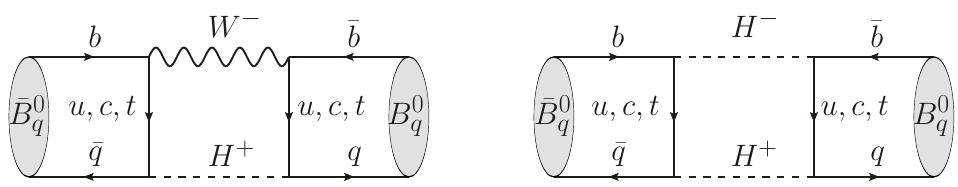
where the operators are defined (for q = d, s )